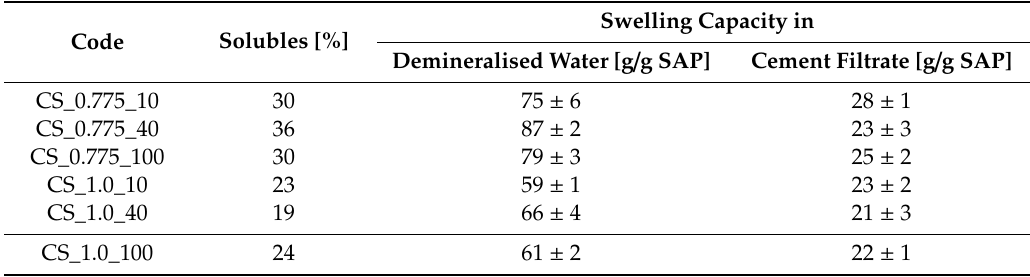
Table 3. Characterization of SAPs: solubles, swelling capacity in demineralised water and cement filtrate (n = 3), series 2.